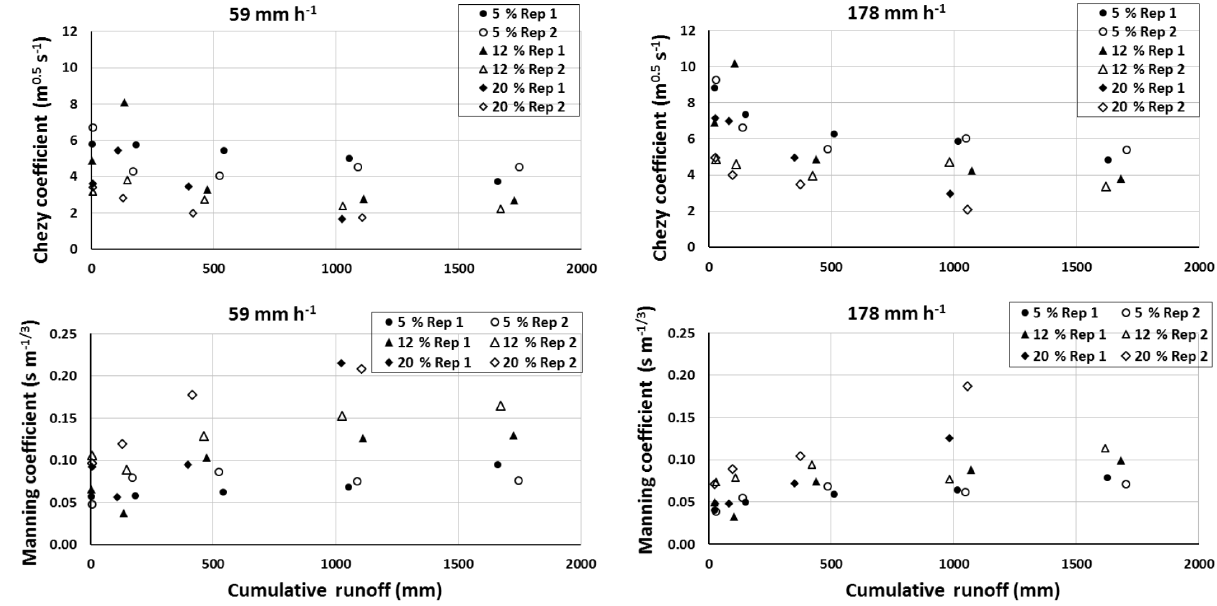
Figure 8. Hydraulic friction factors, Chezy and Manning coefficients, for the full length of the plots as a function of cumulative runoff for 59 and 178mmh − 1 rainfall intensities.